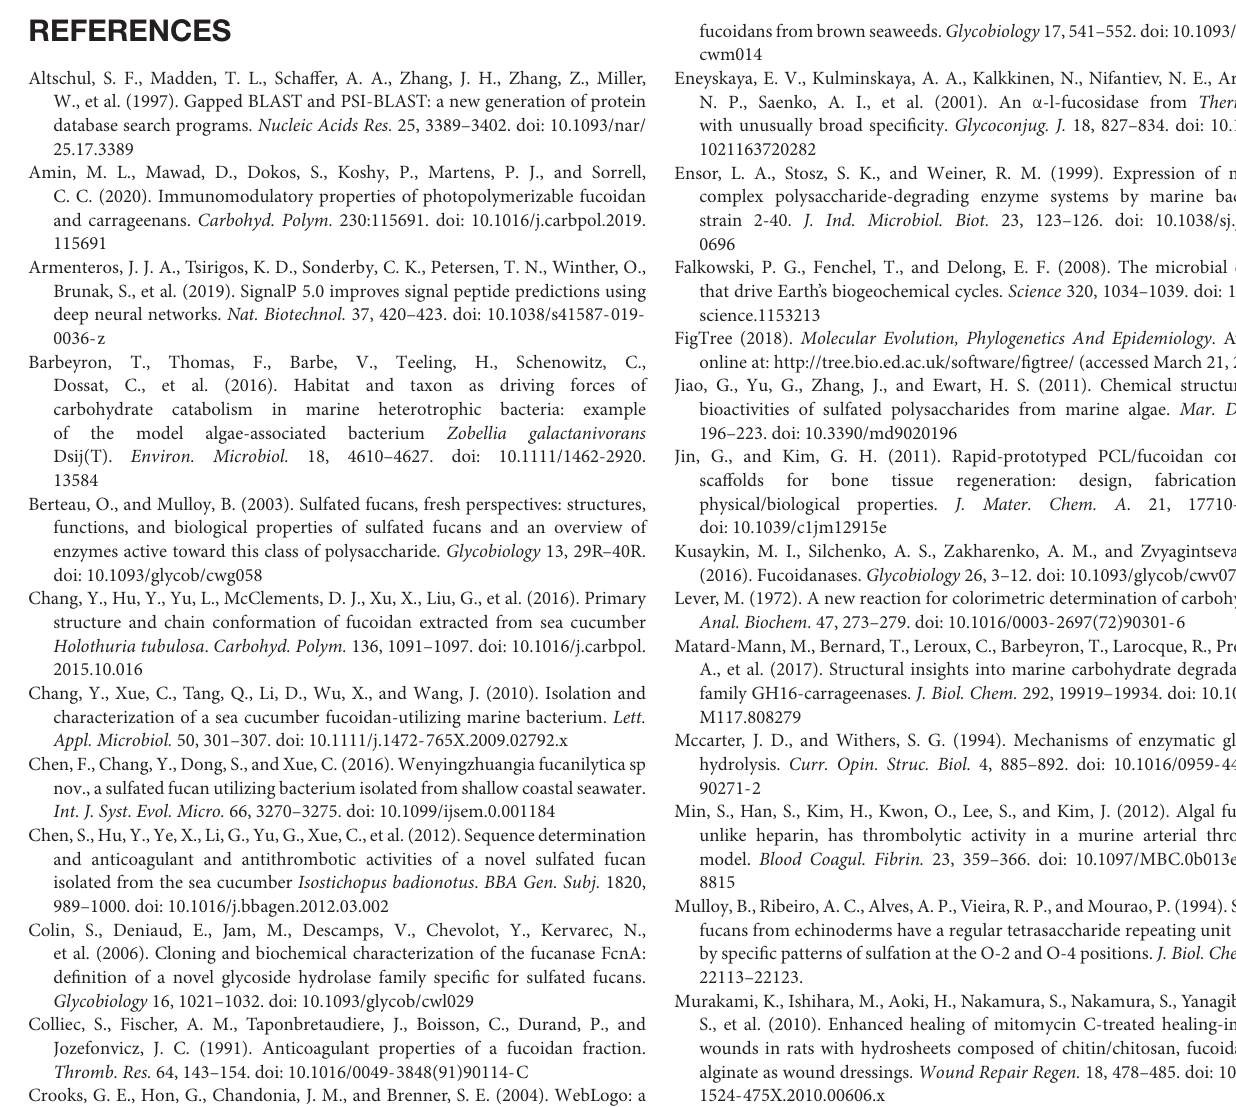
FIGURE S11 | SDS-PAGE analysis of the mutants. M: M w standard markers; Line 1: control group; Line 2: cell lysate supernatant of mutant D206E; Line 3: cell lysate supernatant of mutant E264Q; Line 4: the purified D206E; Line 5: the purified E264Q. The over-expressed proteins in cell lysate supernatants were indicated with red rectangles. TABLE S1 | The forward and reverse primers of FunA and its mutants. TABLE S2 | The enzymatic activities of FunA hydrolyzed sulfated fucans from brown algae. TABLE S3 | Effect of metal ions and chemicals on the activity of